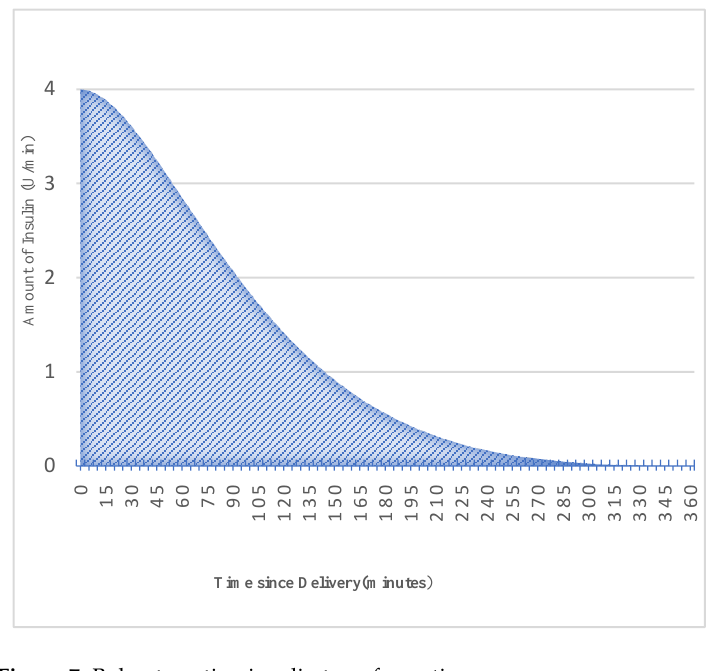
Figure 7. Bolus-to-active-insulin transformation curve.